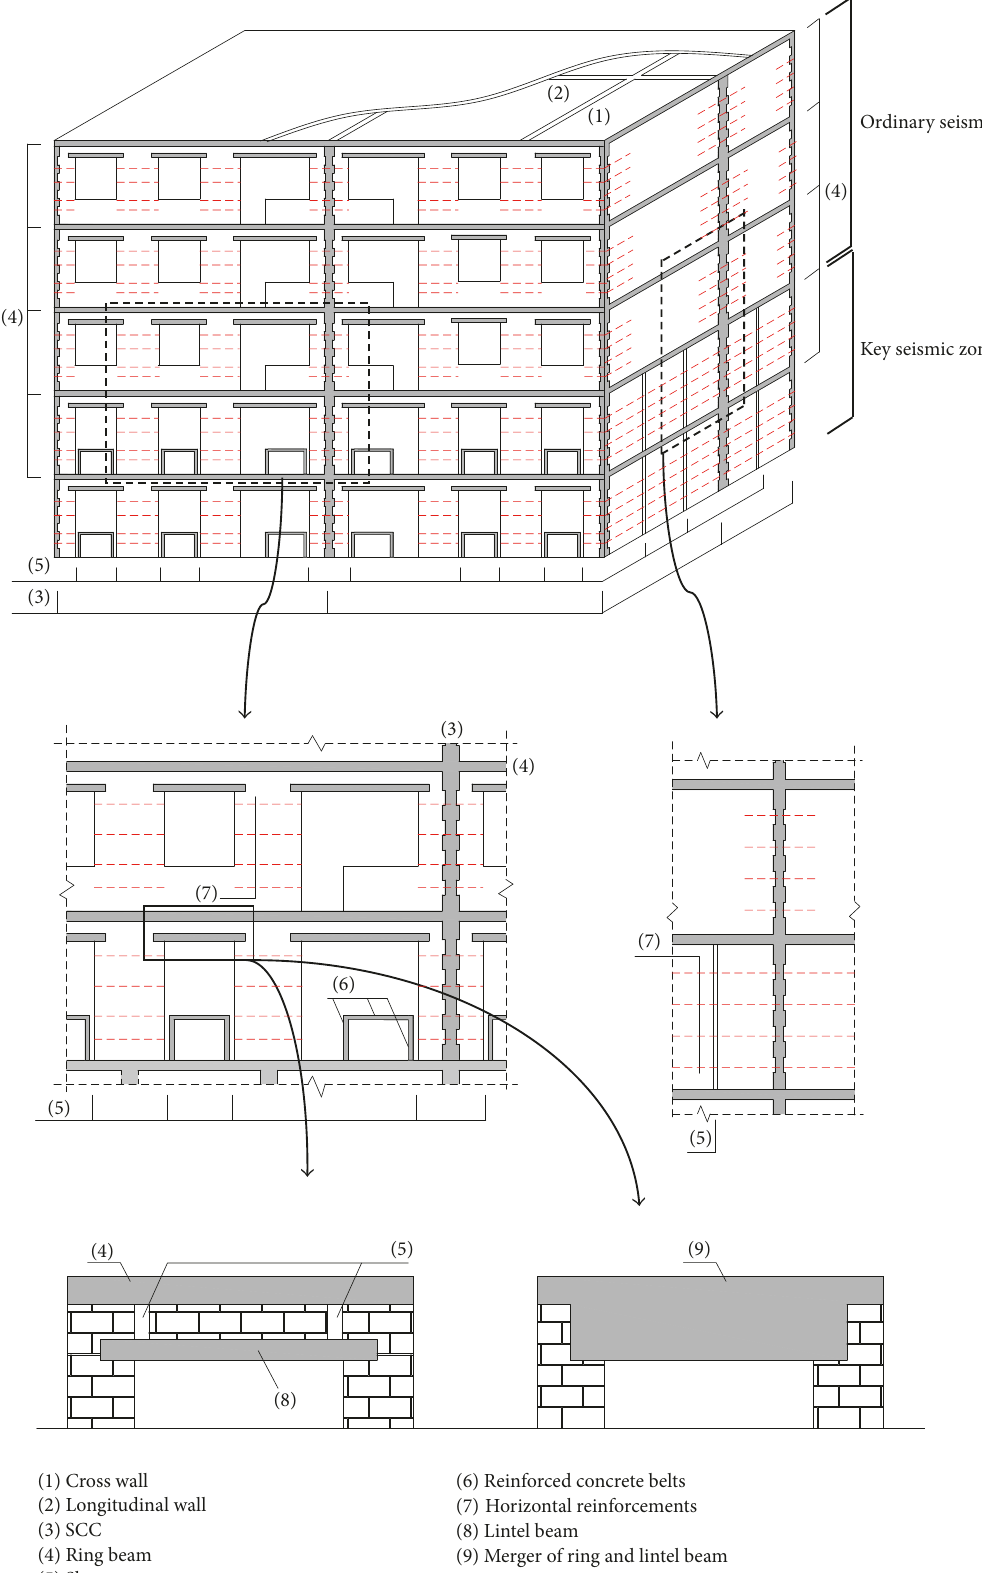
Figure 4: Construction strategy of rocking multistory masonry